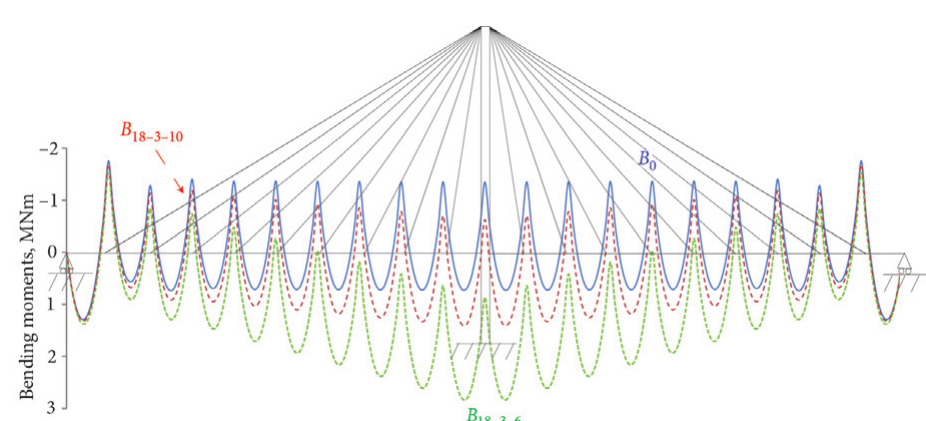
Fig. 8. Comparison between the target bending moments and the bending moments obtained when the structure includes 3 construction joints and is built on 6 or 10 temporary supports